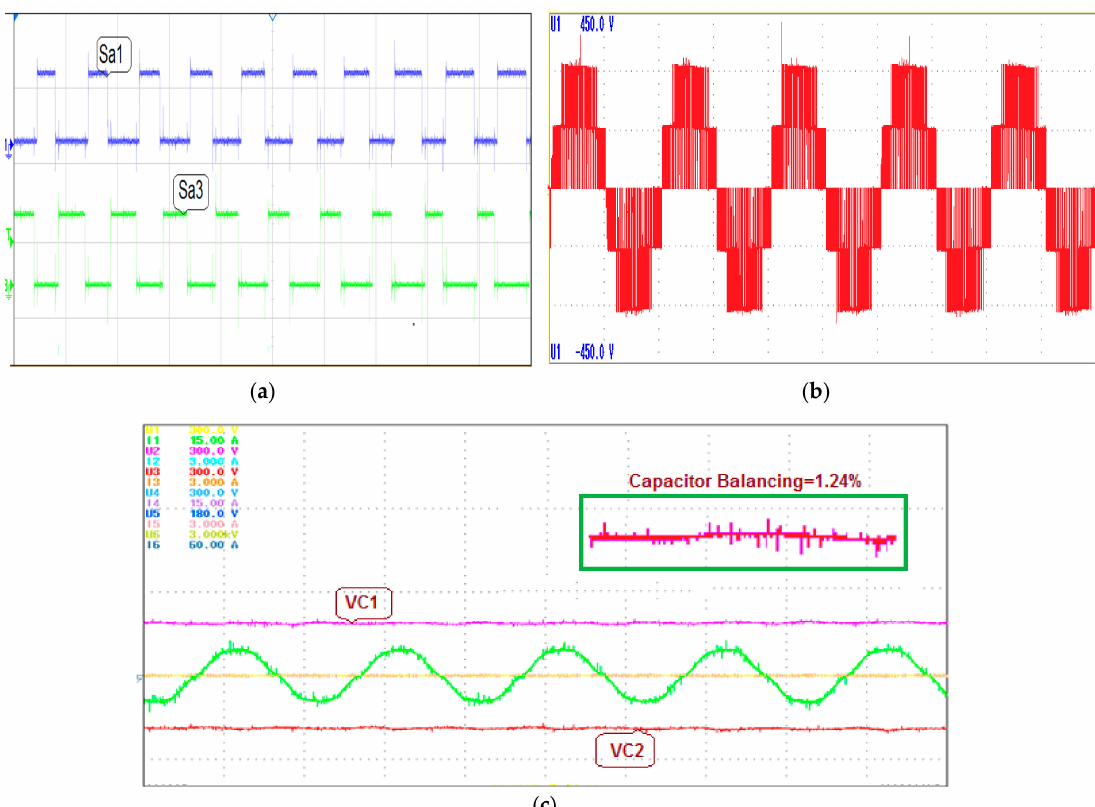
Figure 18. Proposed 3-phase 4-leg NPC inverter with effectual 3D-SVM ( a ) switching pulses; ( b ) 3 level stepped inverter output voltage; and ( c ) capacitor balancing